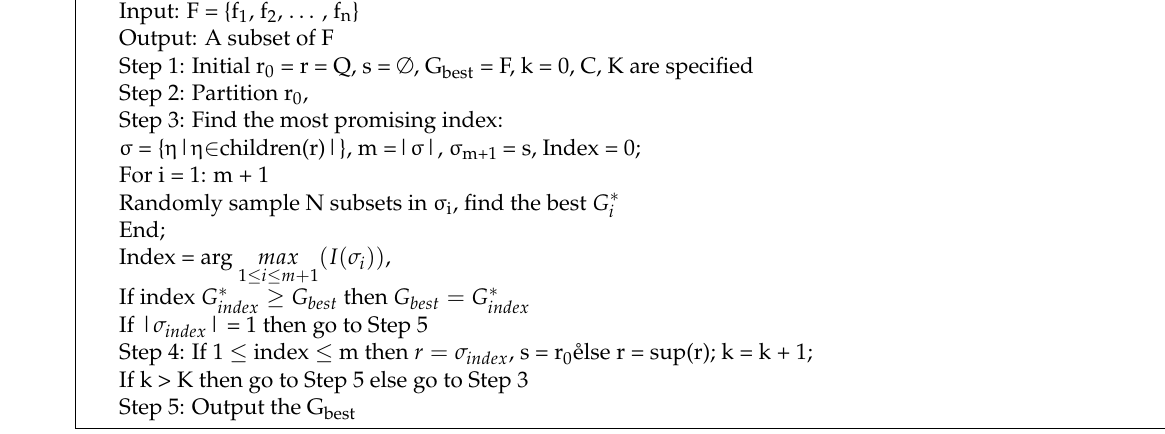
Table 5. The feature selection